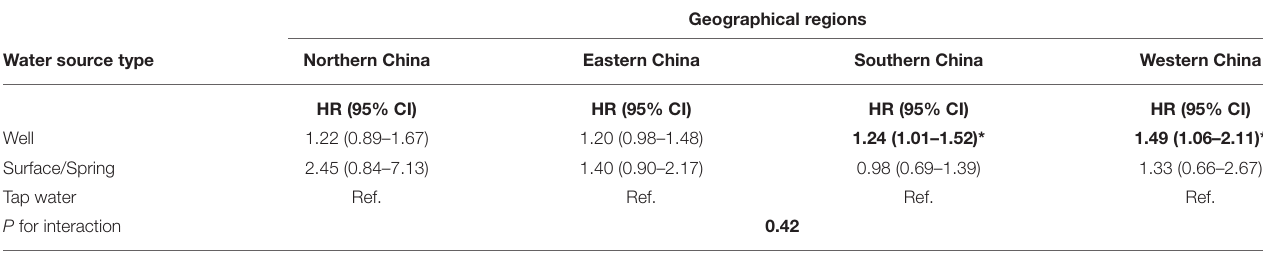
TABLE 5 | Subgroup analyses for the association between the water source and OA across different regions.